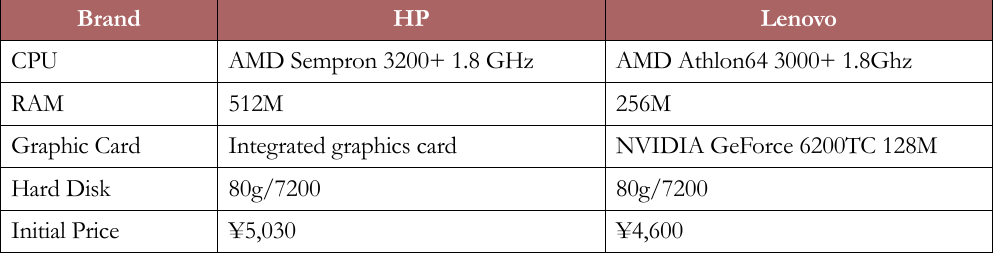
Table 3. Property information of Product 1 and Product 2